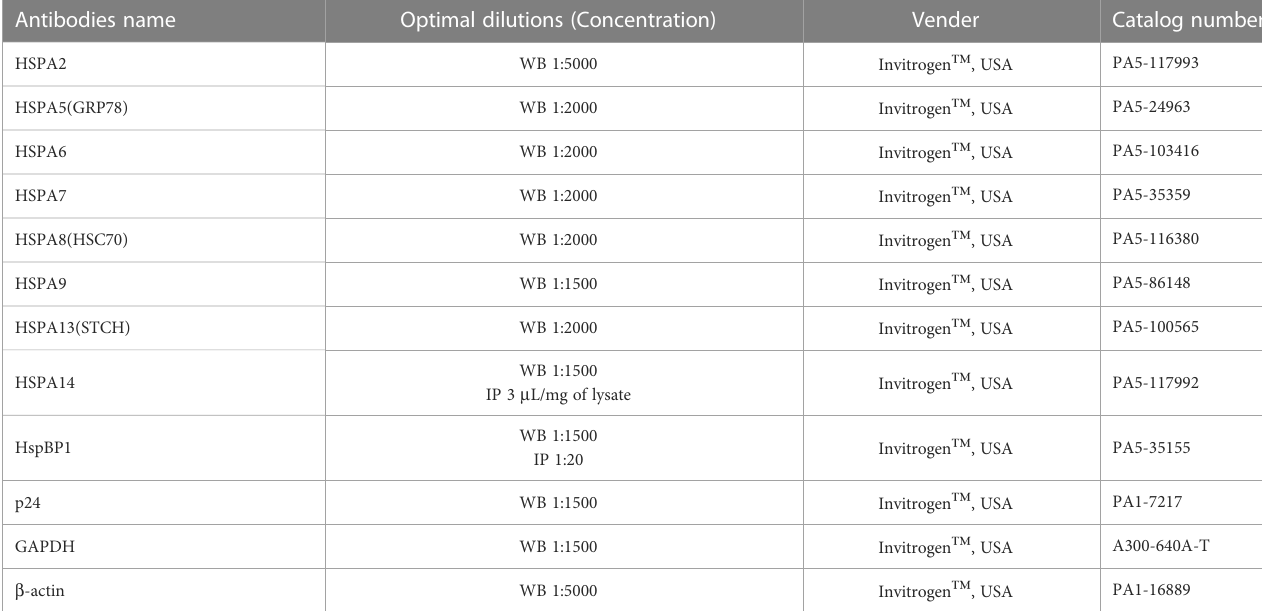
TABLE 3 List of the antibodies used for immunoblotting and immunoprecipitation assays. Antibodies name Optimal dilutions